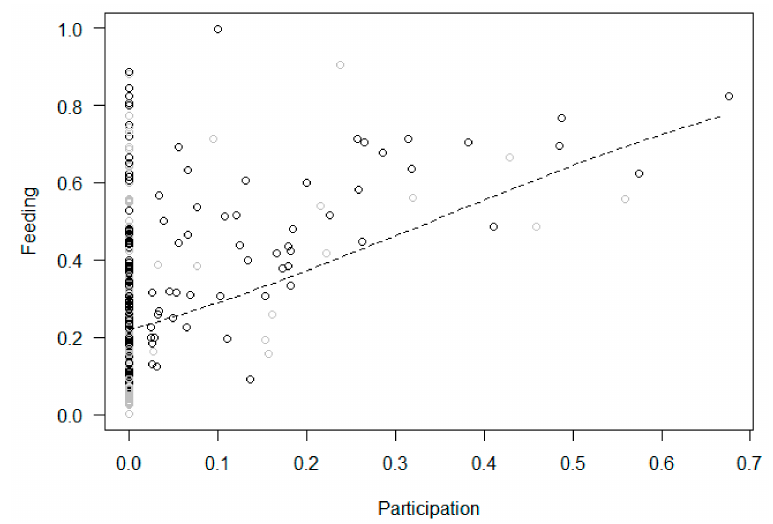
Figure 6. Feeding (i.e., proportion of scans that an individual was feeding, out of the total number of scans in which the subject was visible) as a function of participation (i.e., proportion of scans